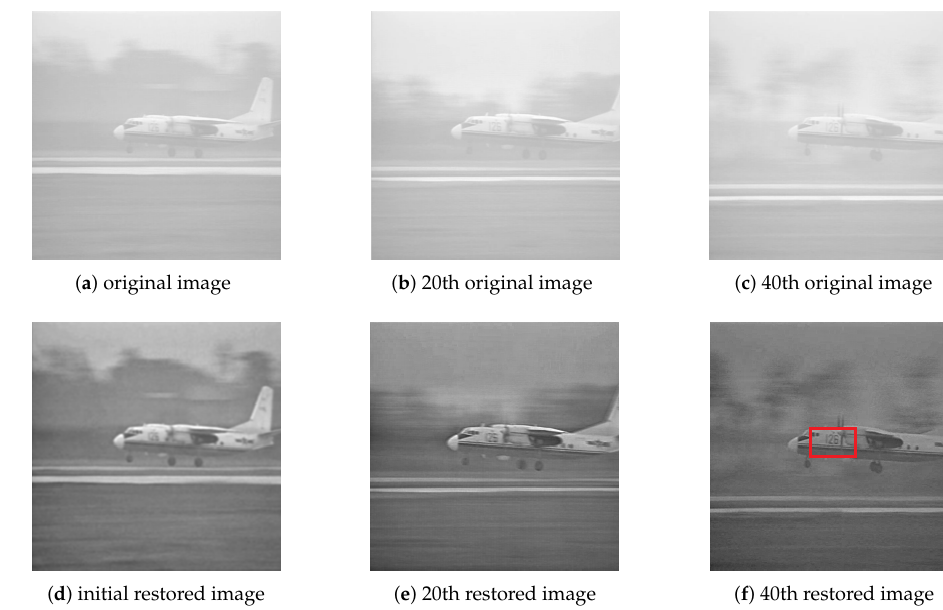
Figure 5. Frames in a video sequence.